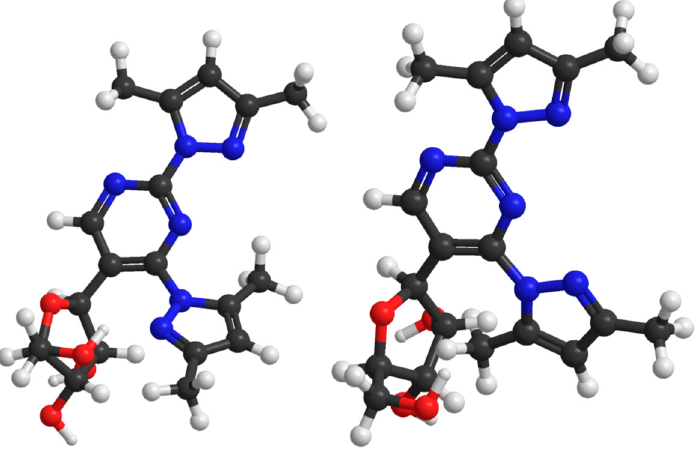
Figure 3. Semi-empirical (PM6) minimized structure for 2,4-bis(3,5-dimethylpyrazol-1-yl) -5-( β - D -ribofuranosyl)pyrimidine ( 4 , left ) and the structure allowing tridentate binding to the N2 atoms of the 3,5-dimethylpyrazolyl groups and the intervening N3 of the pyrimidine ring ( right ). In the latter structure the steric repulsion is much more pronounced than in the